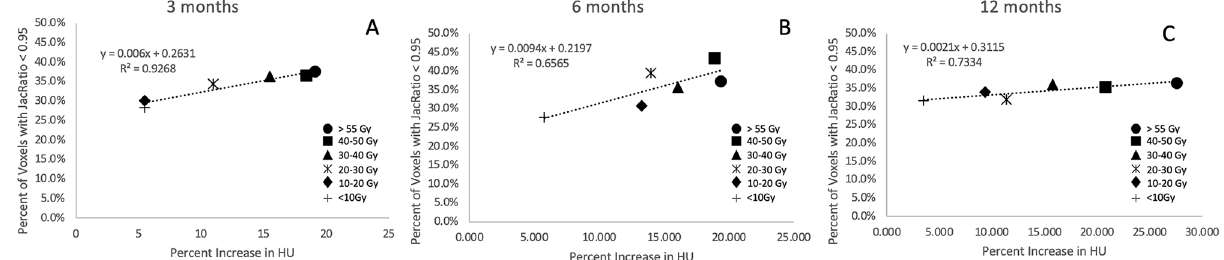
Figure 8. Correlation by dose bin of the percent of voxels with Jacobian ratio less than 0.95 with the percent increase in HU at ( A ) 3 months post RT ( B ) 12 months post-RT. While there are strong correlation coefficients observed at 3 months, the slopes of the best fit lines are very low indicating no real relationship between the two metrics. Each point on the plots represents a dose bin